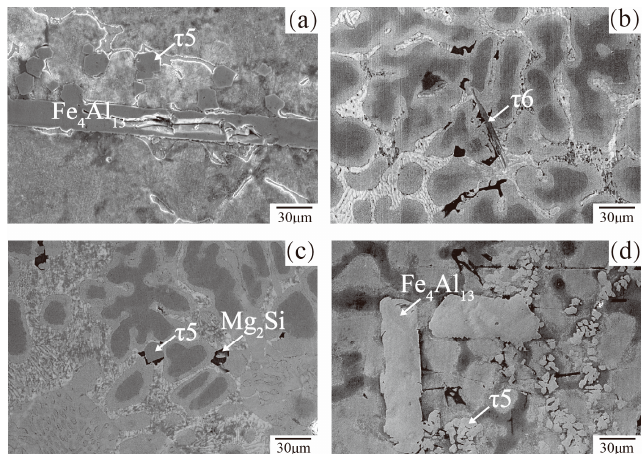
Figure 12. The microstructure of bottom dross: ( a ) 23AZS, ( b ) 23AZS–1.5Mg, ( c ) 23AZS–3Mg, and ( d ) 55AZS.